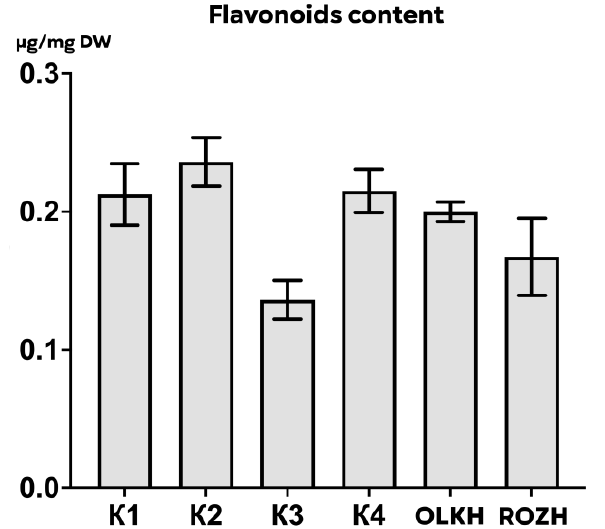
Figure 7. Total flavonoid content in tubers of H. tuberosus growing in contaminated areas and in areas without contamination.